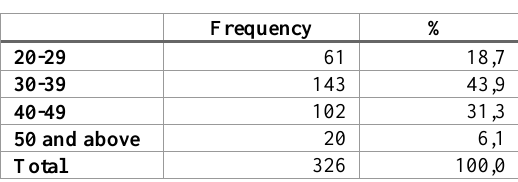
Table 9: Findings on Age